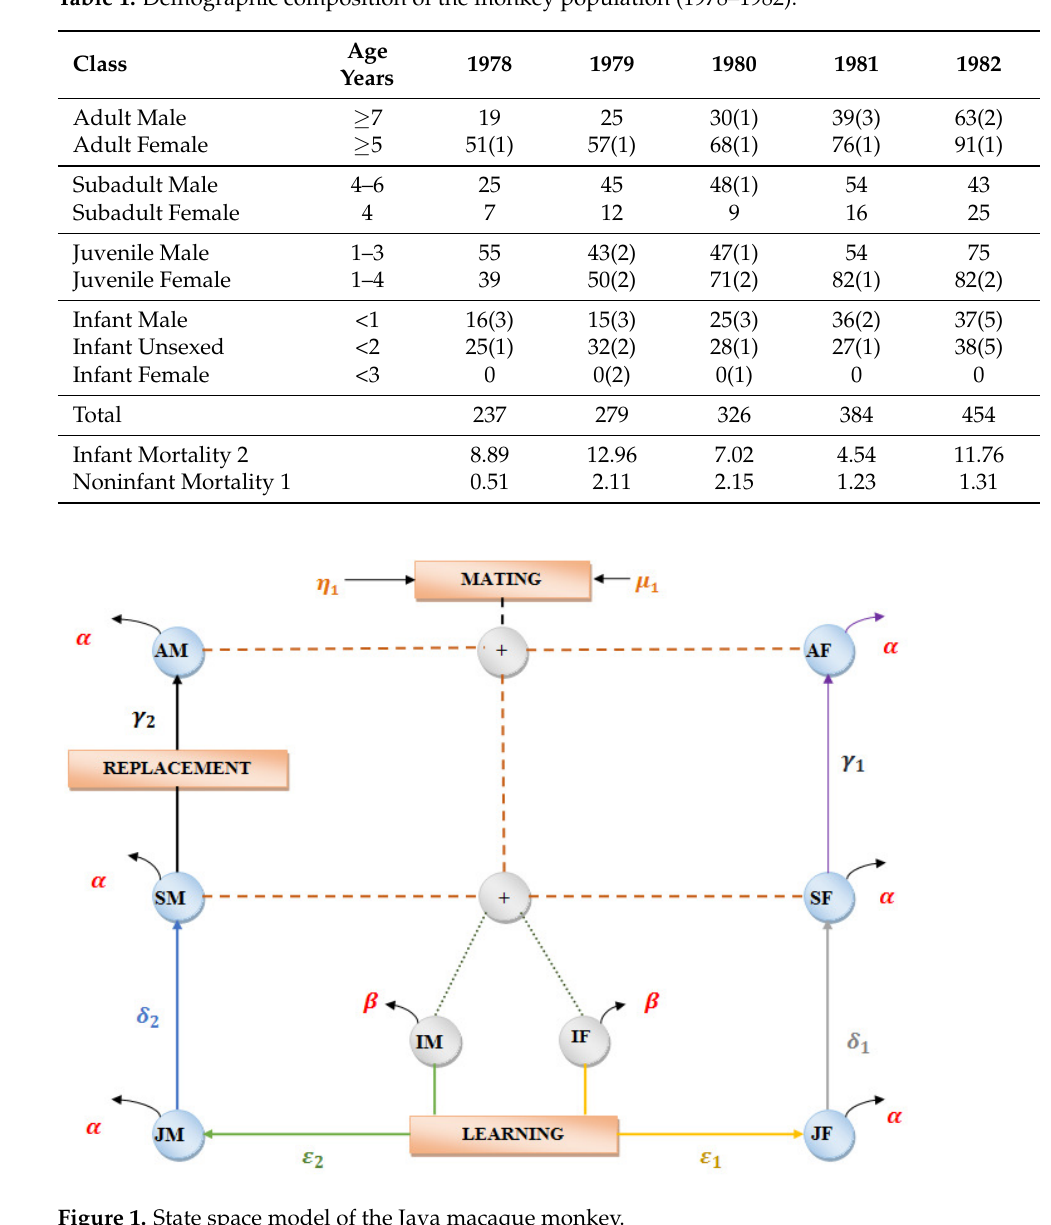
Figure 1. State space model of the Java macaque Figure 1. State Space Model of Java Macaque Monkey.